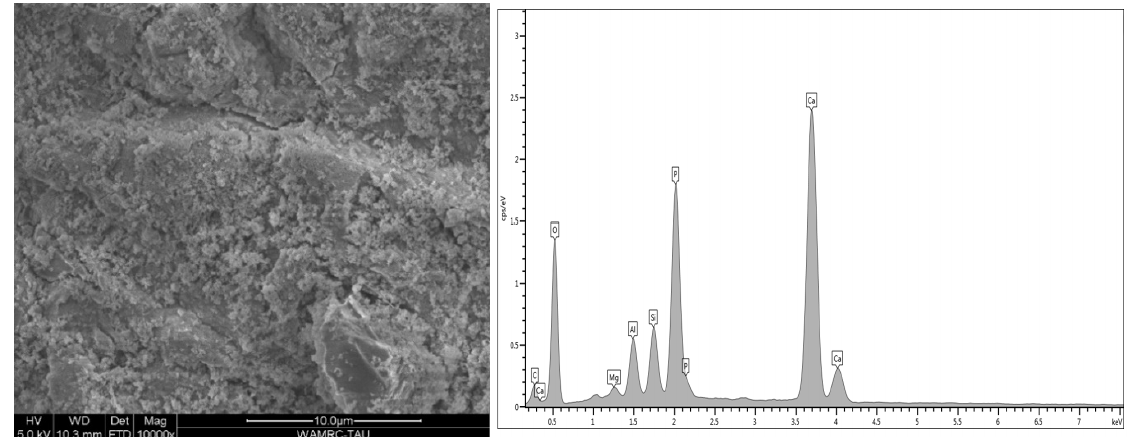
Figure 8. Microscopic image of the air-abraded dentin. The surface is rough and irregular. EDS analysis revealed extra elements as compared to untreated dentin (wt %): Si 5.27%, Al 2.11%.